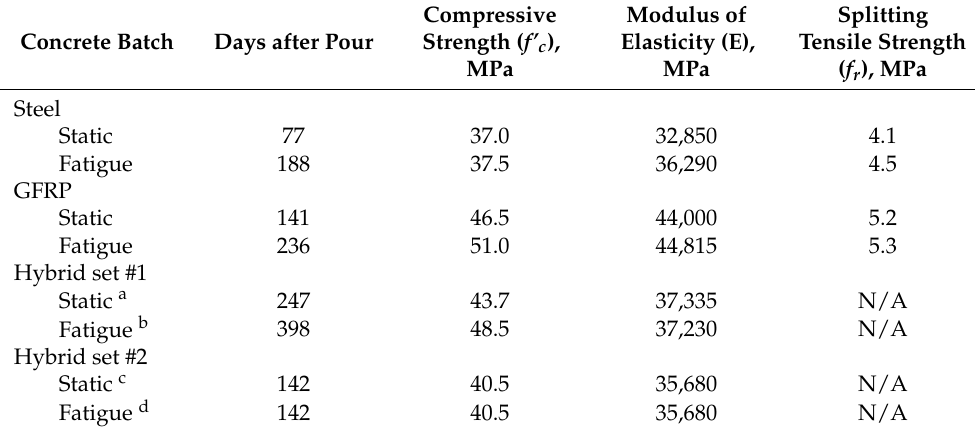
Table 3. Concrete mechanical properties at testing